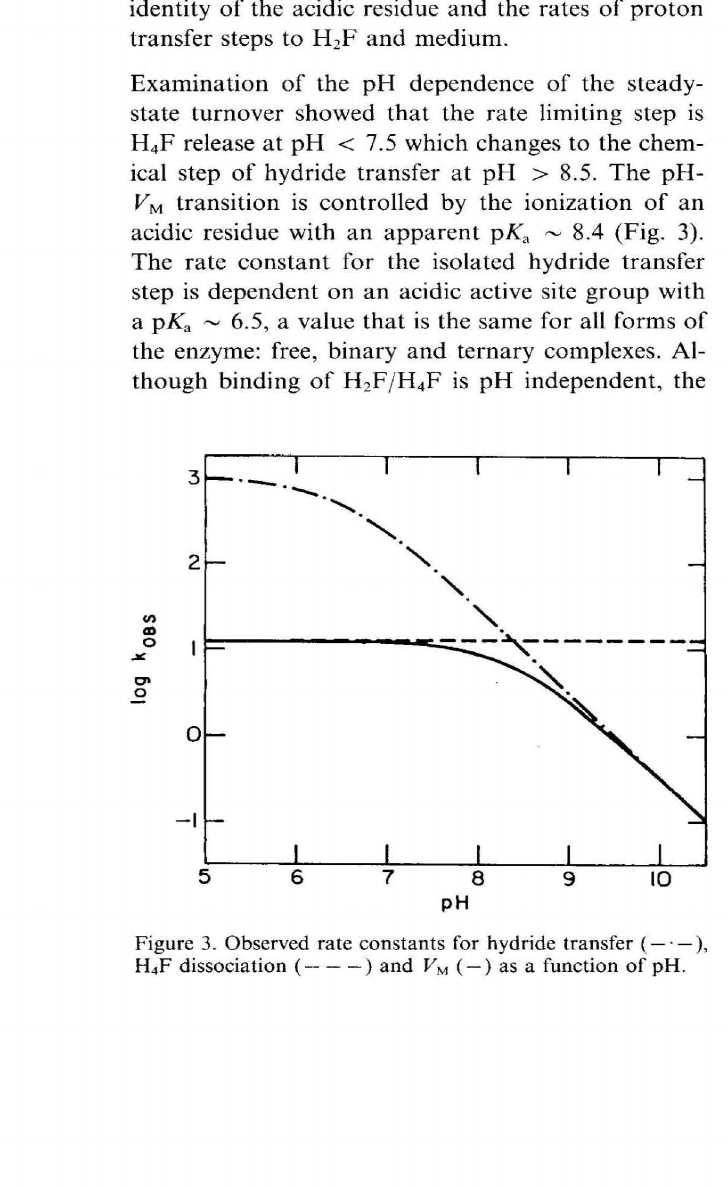
Figure 3. Observed rate constants for hydride transfer (_. - ), H4F dissociation (- - - ) and V M ( - ) as a function of